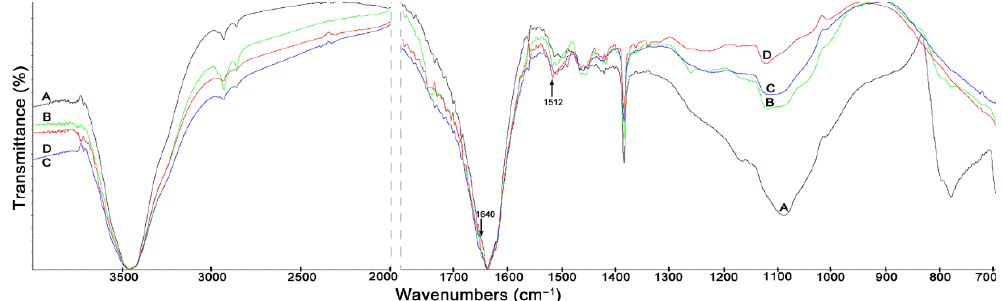
Figure 7. FTIR spectra of lignin isolated from maize stover fractions: ( A ) cobs, ( B ) husks, ( C ) leaves, ( D ) stalks. Table 4. Assignment of selected FTIR bands of functional groups in lignocellulosic stover biomass samples and relative absorbance value for each fraction of maize